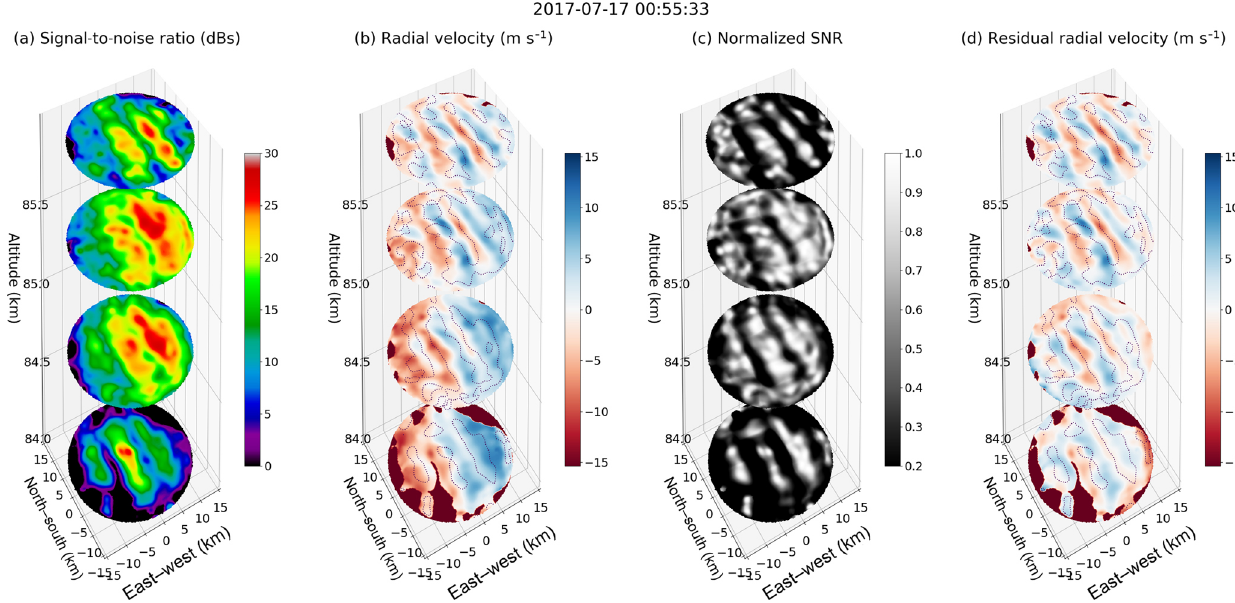
Figure 8. The 3-D contour plots at 00:55:33UT on 17 July 2017, i.e., Event 1, for four selected altitudes: 84, 84.6, 85.2, and 85.8km. The following are shown for each altitude: (a) SNR, (b) radial velocity, (c) locally enhanced SNR, and (d) residual radial velocity. Contours on locally enhanced SNR are overplotted in both velocity plots.